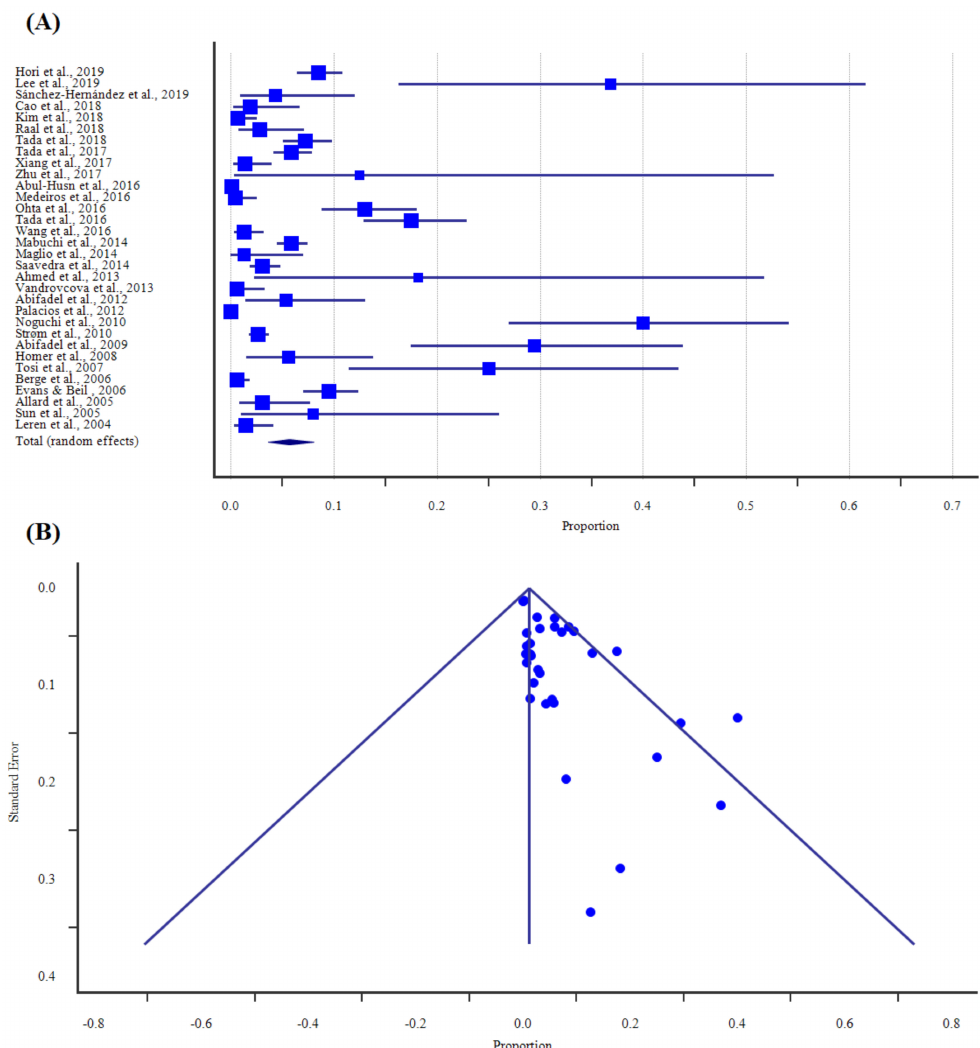
Figure 1. Forest plots ( A ) and funnel plots ( B ) of PCSK9 mutation associated with